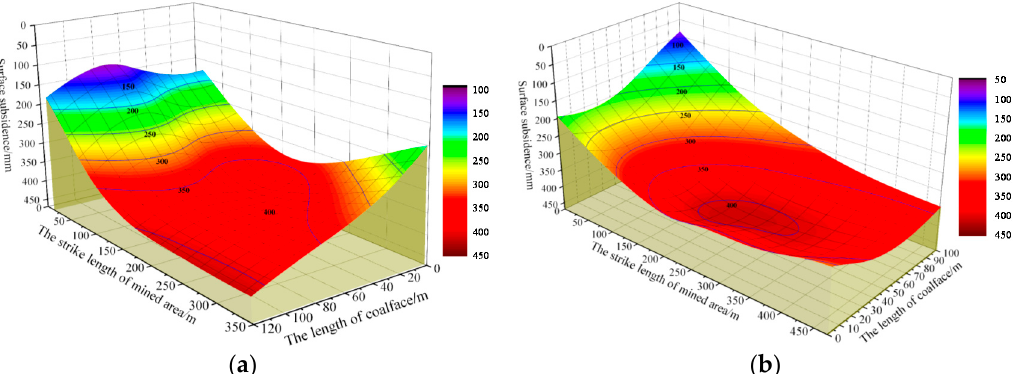
Figure 14. The surface subsidence situations after mining. ( a ) No. 6 backfilling face; ( b ) No. 12706 backfilling face.